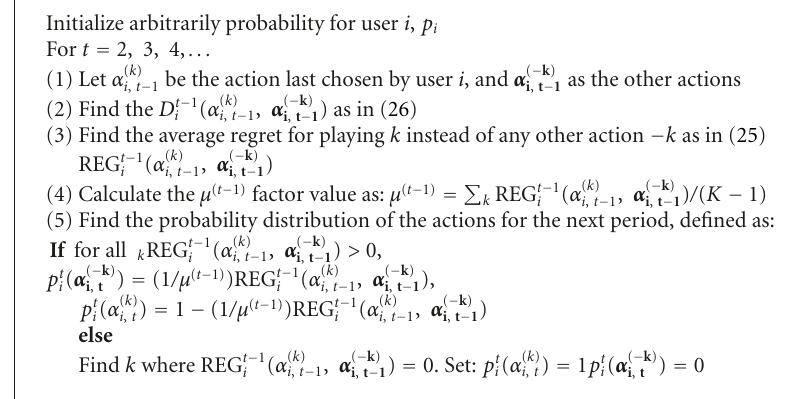
Algorithm 1: Regret-matching learning algorithm.